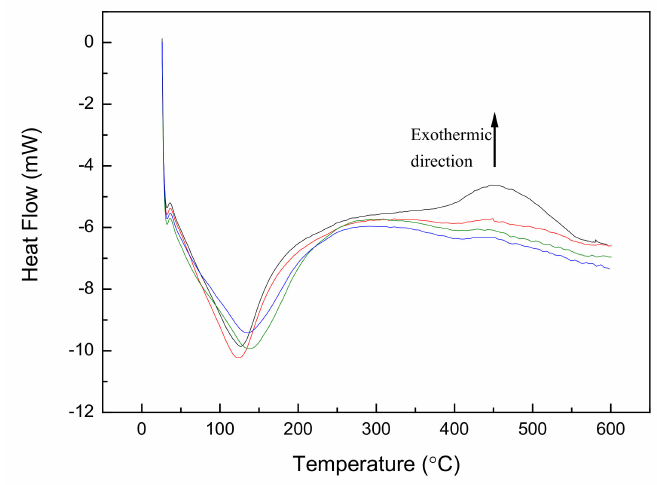
Figure 4. DSC endothermic and exothermic profiles of V r300 (black), V r350 (red), V r400 (green), and V r450